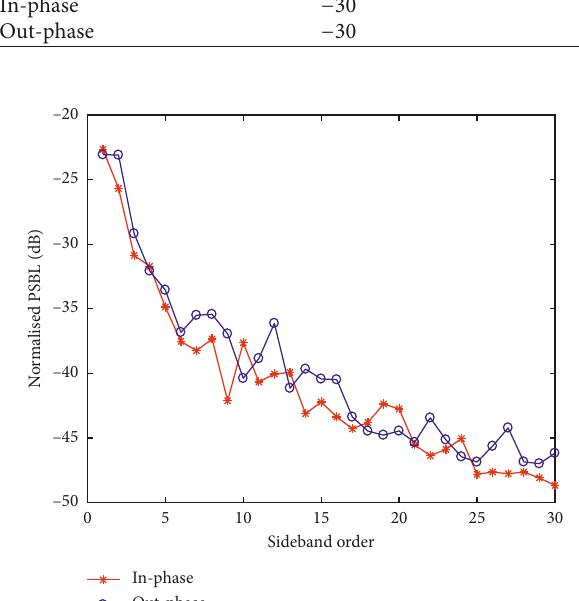
Figure 13: Sideband level of in-phase and out-phase excitation.